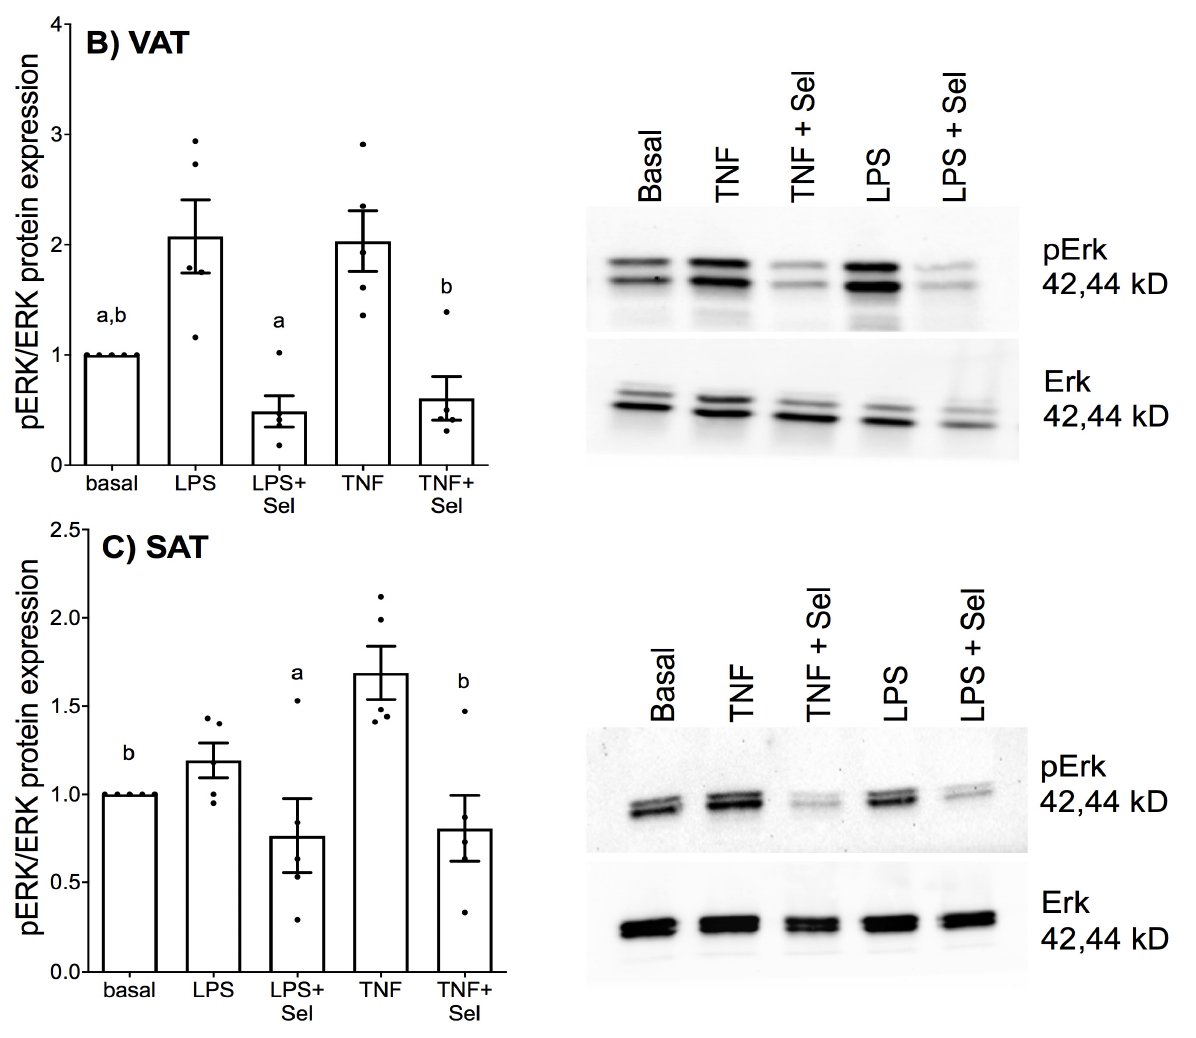
Figure 11. Effect of selenium on ERK activation in human placenta, and VAT and SAT from pregnant women. ( A ) Placenta ( n = 5 patients), ( B ) VAT ( n = 5 patients) and ( C ) SAT ( n = 5 patients) were incubated with or without 10 µM sodium selenite (Sel) overnight and then stimulated with 10 µg/mL LPS or 10 ng/mL TNF- α for a further 15 min. The protein expression of phosphorylated ERK1 (pERK) and total ERK1 was analysed by Western blotting; pERK protein expression was normalised to total ERK expression. A Representative western blot from one patient is shown. For all graphs, the data were calculated relative to basal expression and displayed as mean ± SEM with data points representing five individual experiments. a p ≤ 0.05 vs. LPS, b p ≤ 0.05 vs. TNF; repeated measures one-way